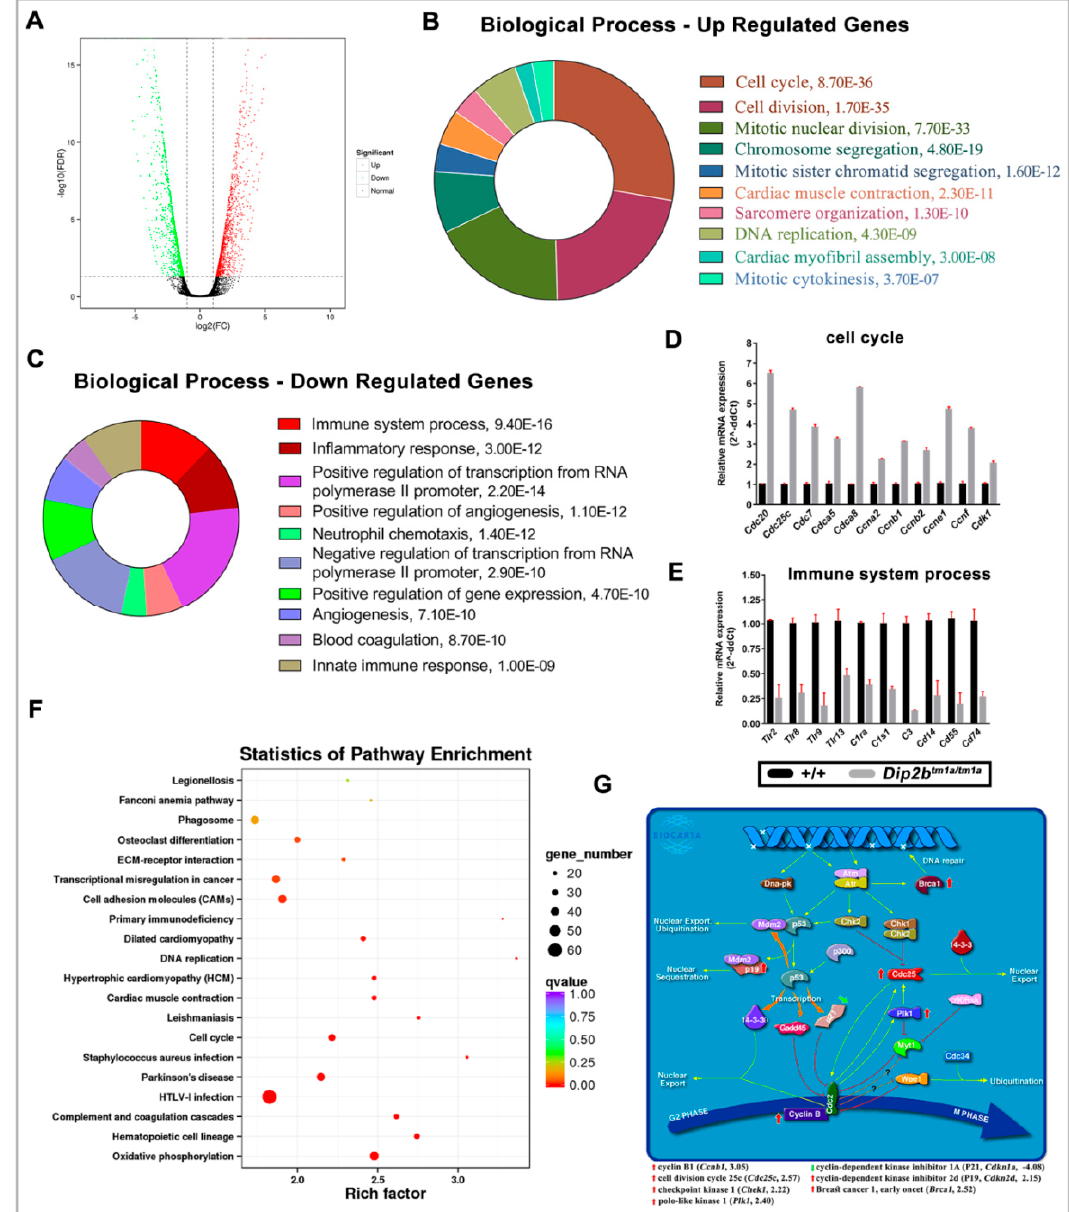
Figure 6. E18.5 Lung transcriptome analysis defined by FDR < 0.01 and Fold change > 2: ( A ) Volcano plots of differentially expressed genes (DEGs). The red and green dots represent up-regulated and downregulated genes respectively; ( B – E ) Gene ontology (GO) analysis of DEGs; ( B , C ) Pie charts of top 10 overrepresented biological process terms from upregulated and downregulated genes respectively; ( D , E ) The mRNA expression levels of 11 & 10 genes annotated under biological process term ‘Cell cycle’ and ‘immune system process’ determined by qPCR. The red error bars represents standard deviation; ( F , G ) Pathway enrichment analysis; ( F ) KEGG pathway enrichment scatter plot. Each circle represents a KEGG pathway. The Y -axis represents the name of the pathway and the X -axis indicates Enrichment Factor, indicating the proportion of the annotated genes in the pathway. The lowest Q value represents the most significant pathway; ( G ) Biocarta G2 / M phase transition pathway. A total of seven DEGs were annotated. Red arrow represents upregulated genes while green arrow represents downregulated genes.